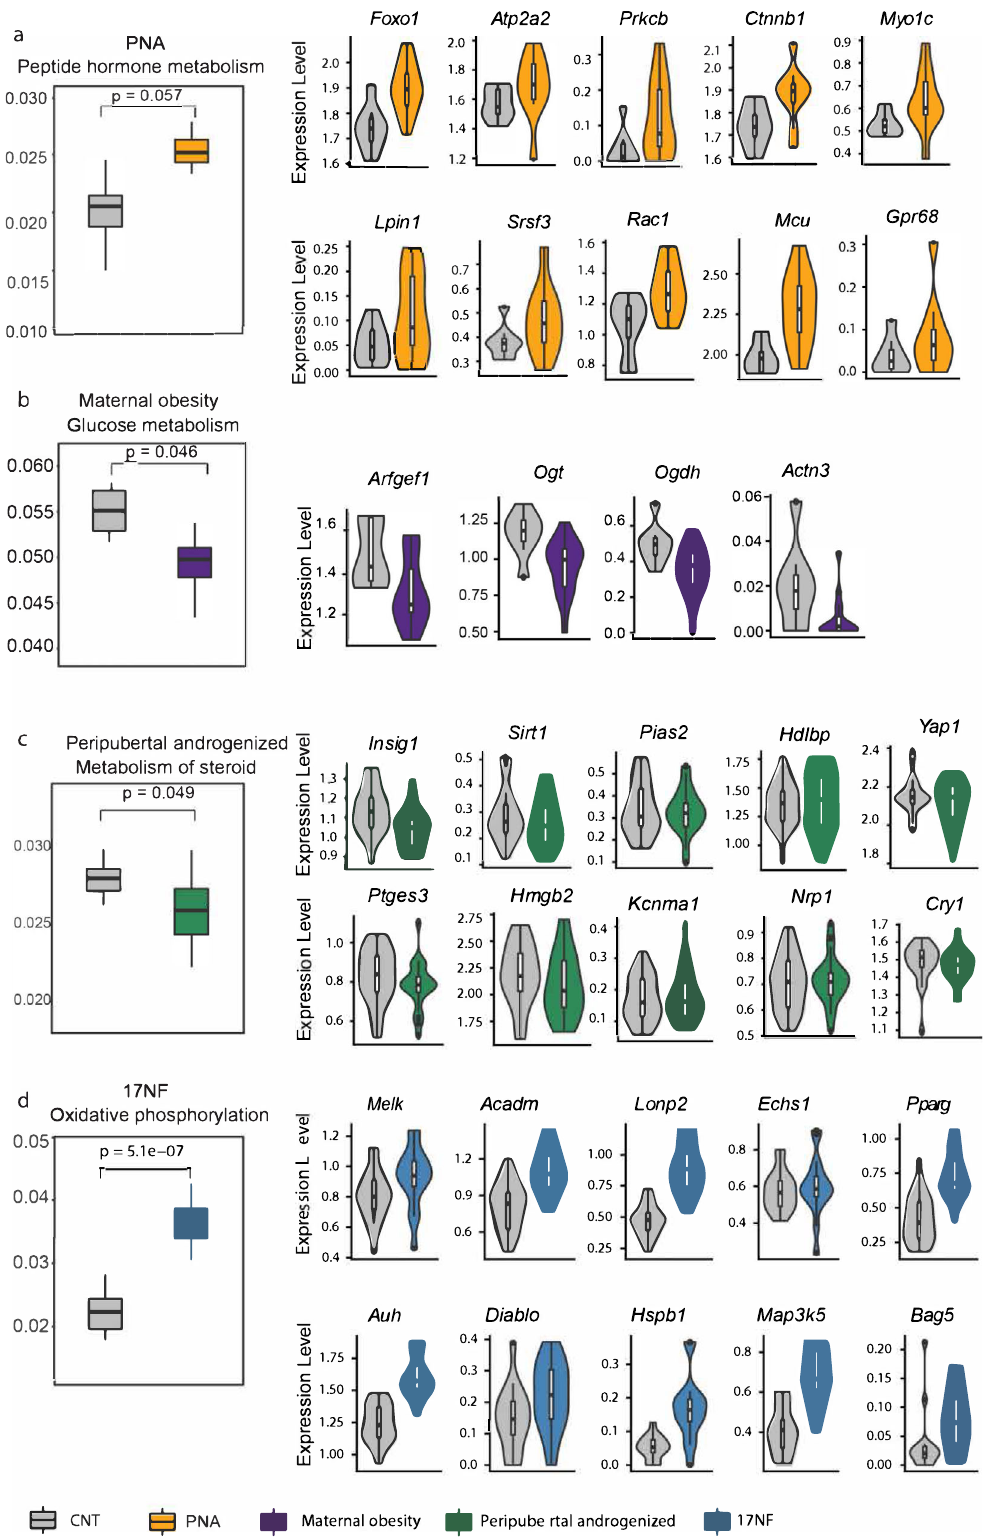
Fig. 5 Metabolic pathway analysis of MII oocytes. a – d Boxplot showing the key metabolic pathways in PNA ( n = 8/3 animals in control + vehicle, n = 10/2 animals in prenatal DHT), Maternal obesity ( n = 8/3 animals in control, n = 15/3 animalsin maternal obesity), Peripubertal androgenized ( n = 56/8 animals in control + vehicle, n = 67/8 animals in Peripubertal DHT) and 17NF model ( n = 16/3 animals in control, n = 16/3 animals in 17NF), respectively. Violin plot with an overlay of boxplots showing the DEGs expression in each metabolic pathway. For the boxplot within each violin plot, middle lines indicate median values, boxes range from the 25th to 75th percentiles. n number of MII